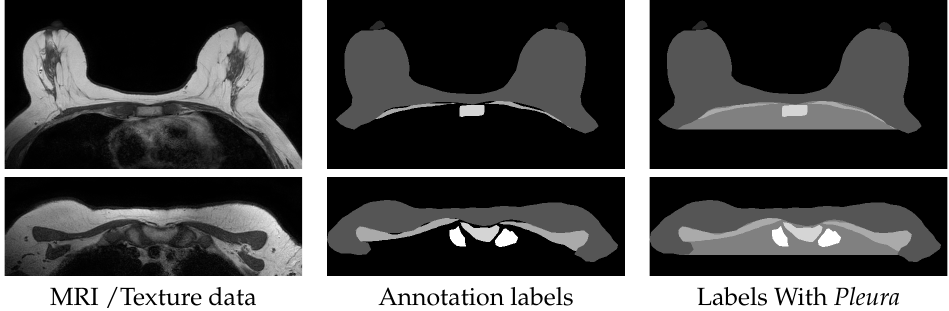
Figure 5. Examples from the Dataset, with background cropped for reader convenience. Of the 27 available exams, 21 were assigned for the training set, 3 for the validation set and 3 for test set. All images were cropped and padded into a square shape, excluding most of the background area, and resized to 256 256 ×